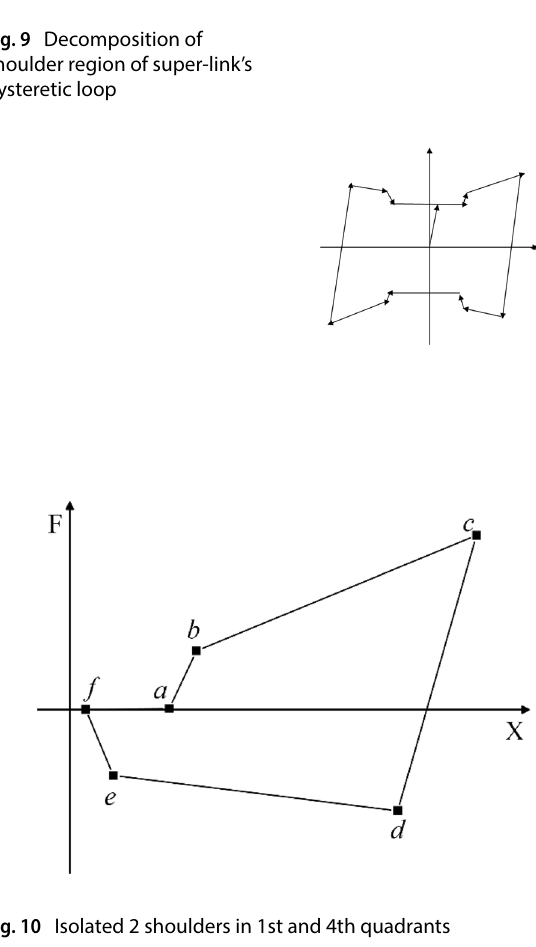
Fig. 10 Isolated 2 shoulders in 1st and 4th quadrants